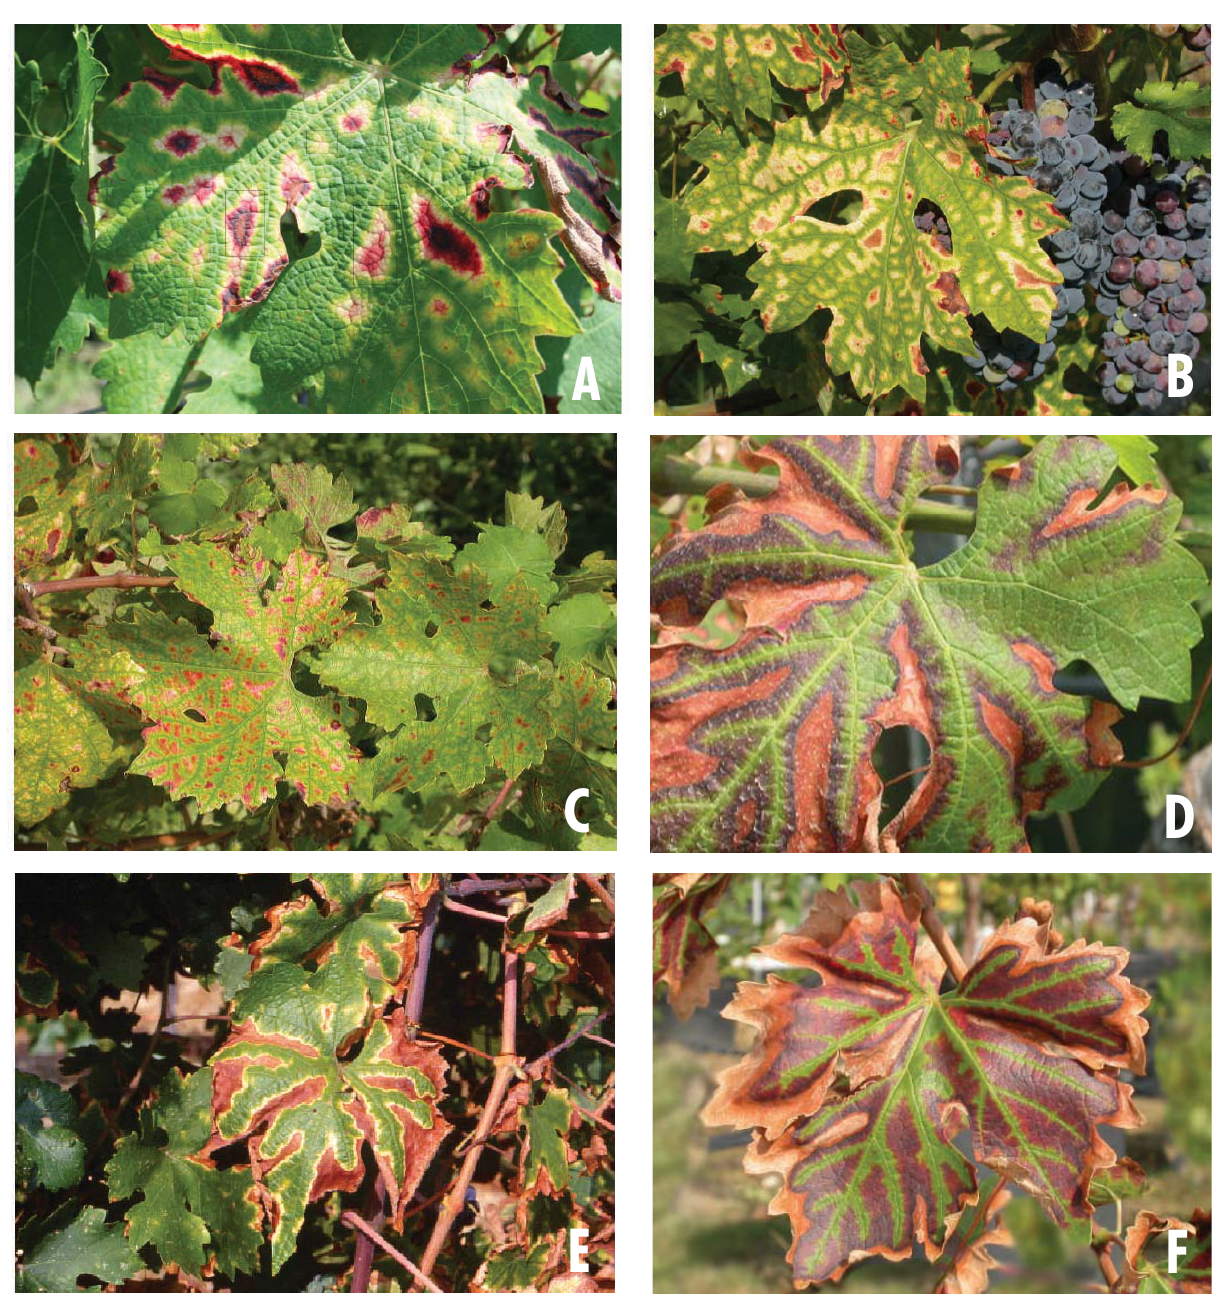
Fig. 2. Some examples of the initial (A–C) and fi nal (D–F) lesion stages associated with ‘grapevine leaf stripe